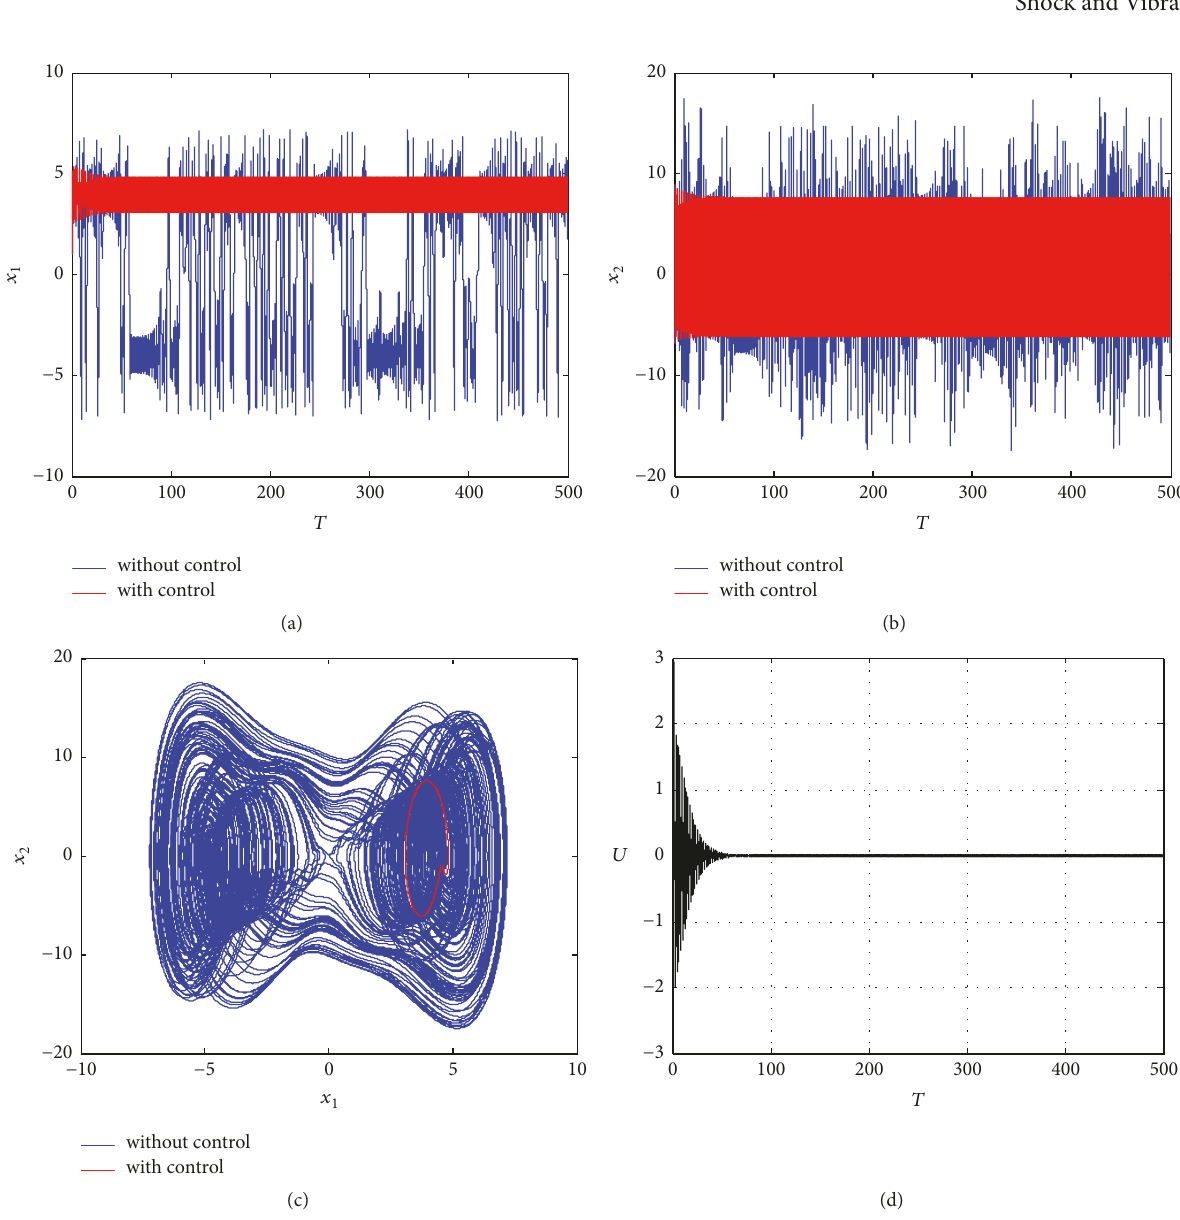
Figure 8: (a) Displacement. (b) Velocity. (c) Phase portrait. (d) Control